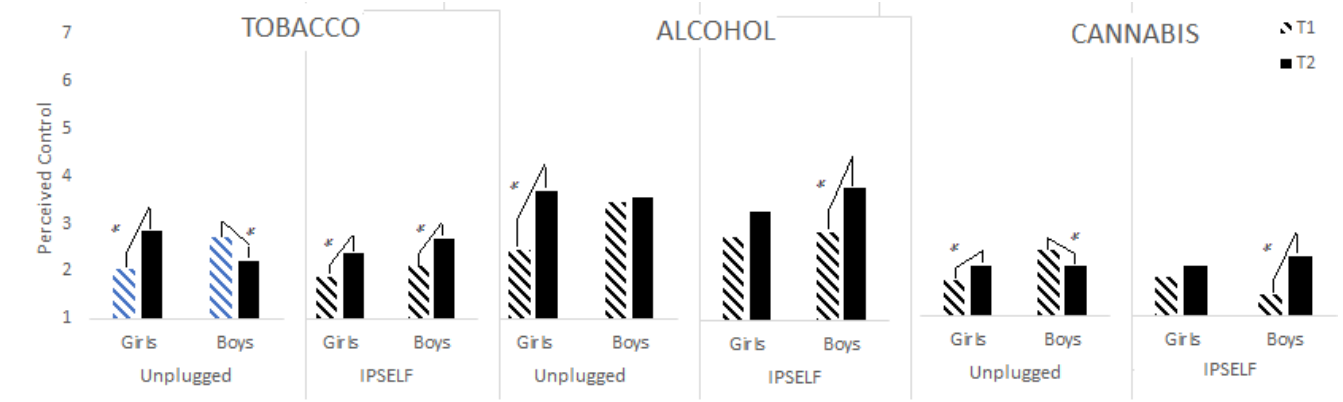
Figure 3. Change in substance use control over time by program and gender. * represents the signifiant effect.